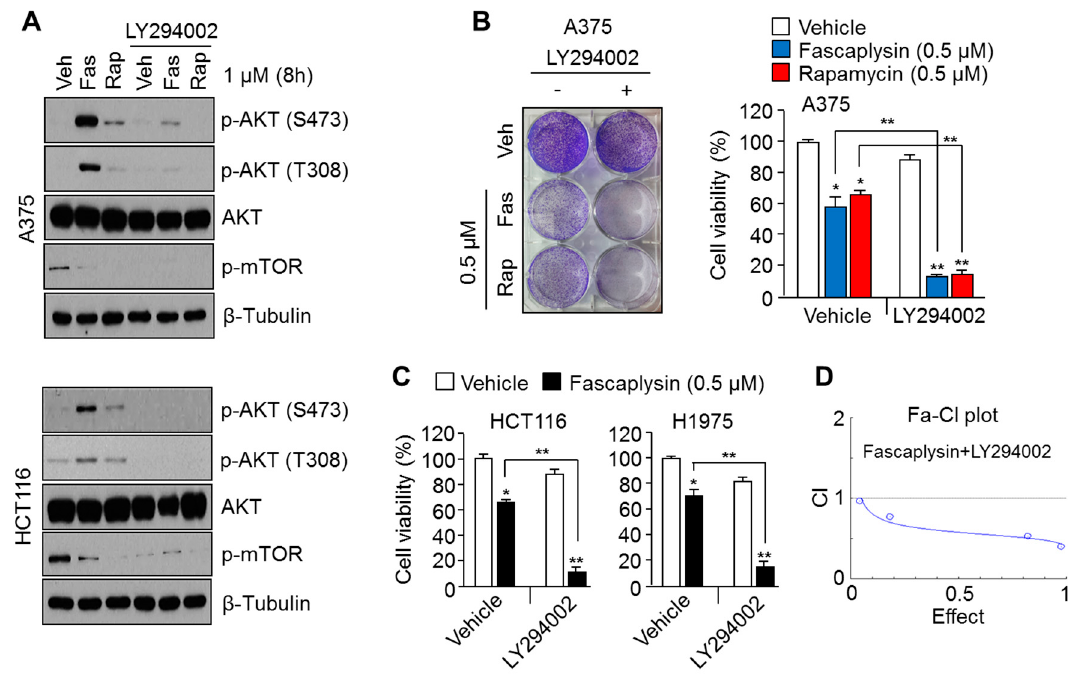
Figure 2. Pharmacological targeting of fascaplysin-induced AKT phosphorylation enhances the anti-cancer effect of fascaplysin. ( A ) A375 and HCT116 cells were pre-incubated with 10 µ M of LY294002 for 20 min, and were then further treated with 1 µ M of fascaplysin or rapamycin for 8 h. Protein levels were analyzed by Western blotting. ( B , C ) A375 cells were pre-incubated with 10 µ M of LY294002 for 20 min, and were then treated with 0.5 µ M of fascaplysin or rapamycin for 36 h. The cell viability upon treatment of fascaplysin and LY294002 were measured in HCT116 and H1975 cells. Cell viability was measured by using the crystal violet staining assay described in Methods and Materials. ( D ) A375 cells were incubated with series of dose of fascaplysin and LY294002 for 48 h, and then cell viability was determined by crystal violet assay. The combination index of the synergistic effect of fascaplysin with LY294002 in A375 cells was calculated by the CalcuSyn software 2.1. Values are represented as the mean ± standard deviation (SD) of three independent experiments performed in triplicate; * p < 0.05 and ** p < 0.01.